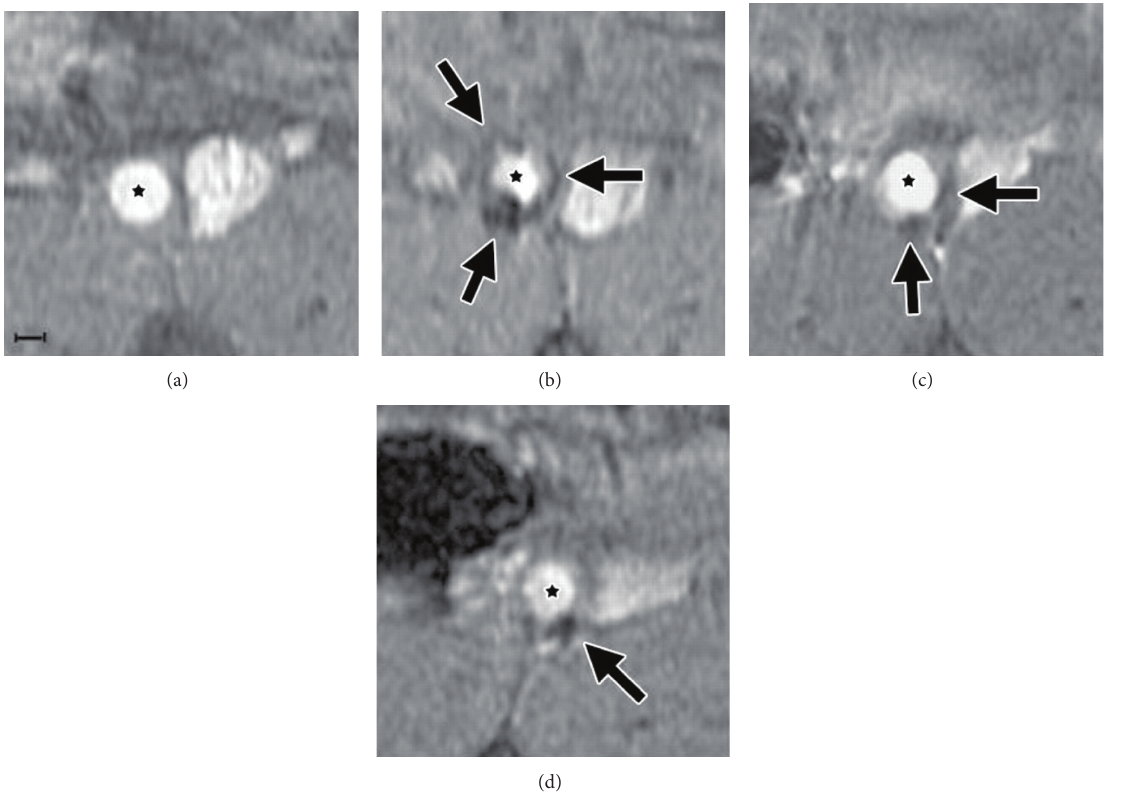
Figure3:TransverseT2 ∗ -weightedmagneticresonanceimages,thespin-spinrelaxationtimemeasuredingradientechosequences,ofasingle murine abdominal aortic aneurysm prior to iron oxide nanoparticle-labeled vascular smooth muscle cell delivery (a) and on postdelivery days 0 (b), 21 (c), and 28 (d). Arrows represent areas of hypointense signal in the aortic wall. The vessel lumen is highlighted with ( 󳀅 ). Scale bar represents 1mm. Figure adapted from